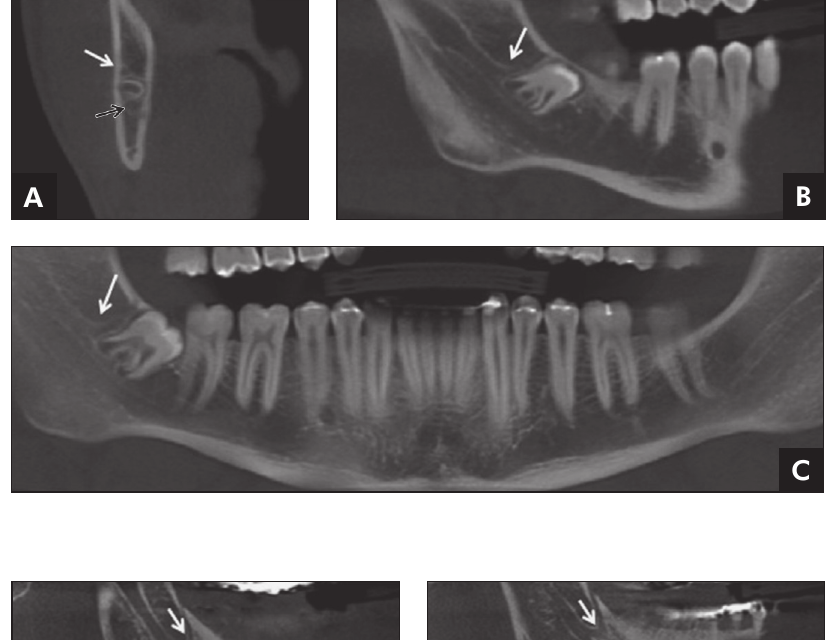
Figure 1 - Unilateral bifurcation (right side) extending to the region of the third molar and adjacent structures (Type 1U). Axial cut ( A ), lateral ( B ) and panoramic ( C ) views. The white arrows indicate the bifurcation and the black arrow indicates the mandibular